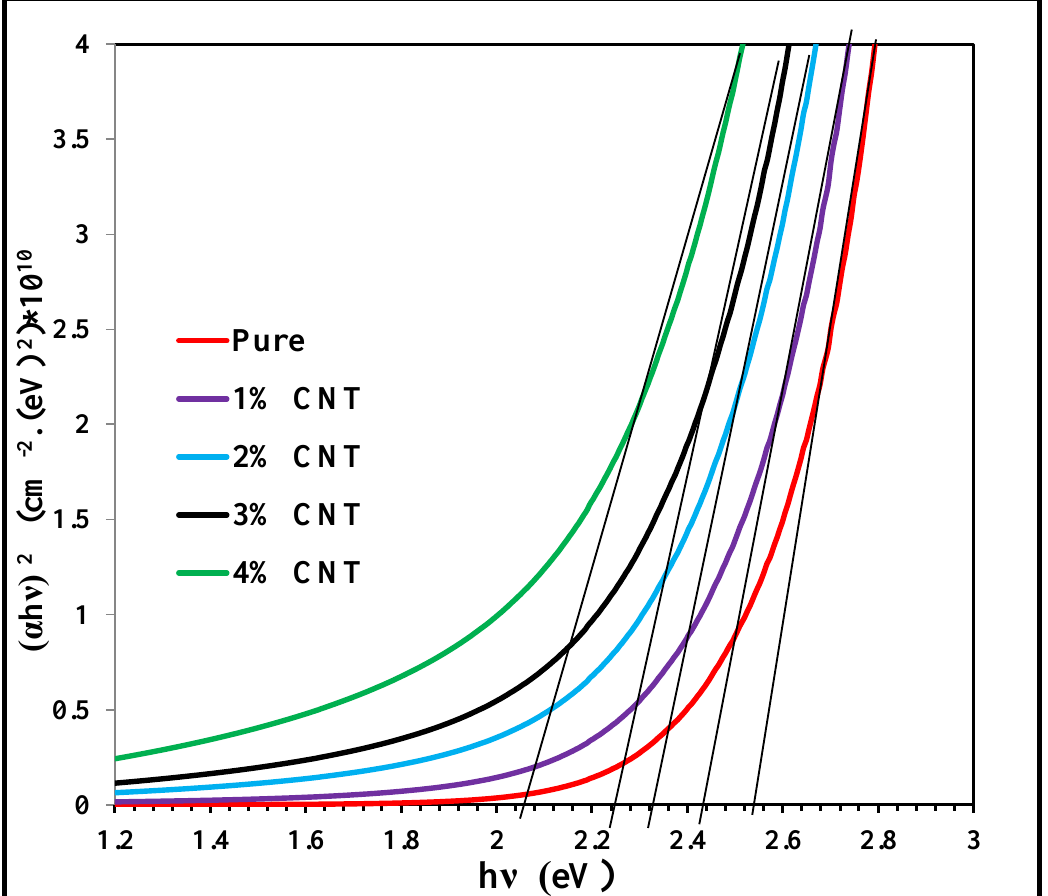
Fig. 6: Direct energy gap of the pure PANI and PANI/MWCNTs nanocomposites.